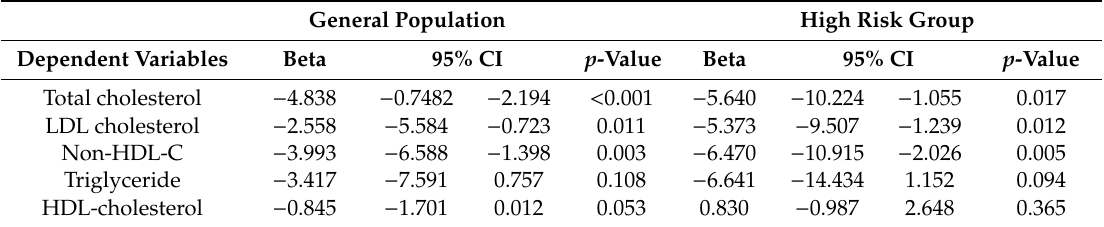
Table 3. Multiple adjusted regression coefficients and 95% confidence intervalsof the association between the Mediterranean diet score and lipid profiles in the general population and high-risk group.